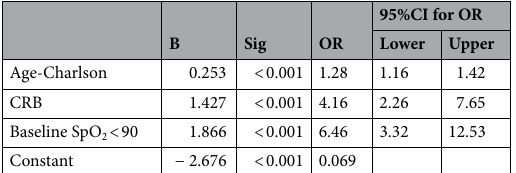
Table 5. Multivariate model for predicting the development of severe